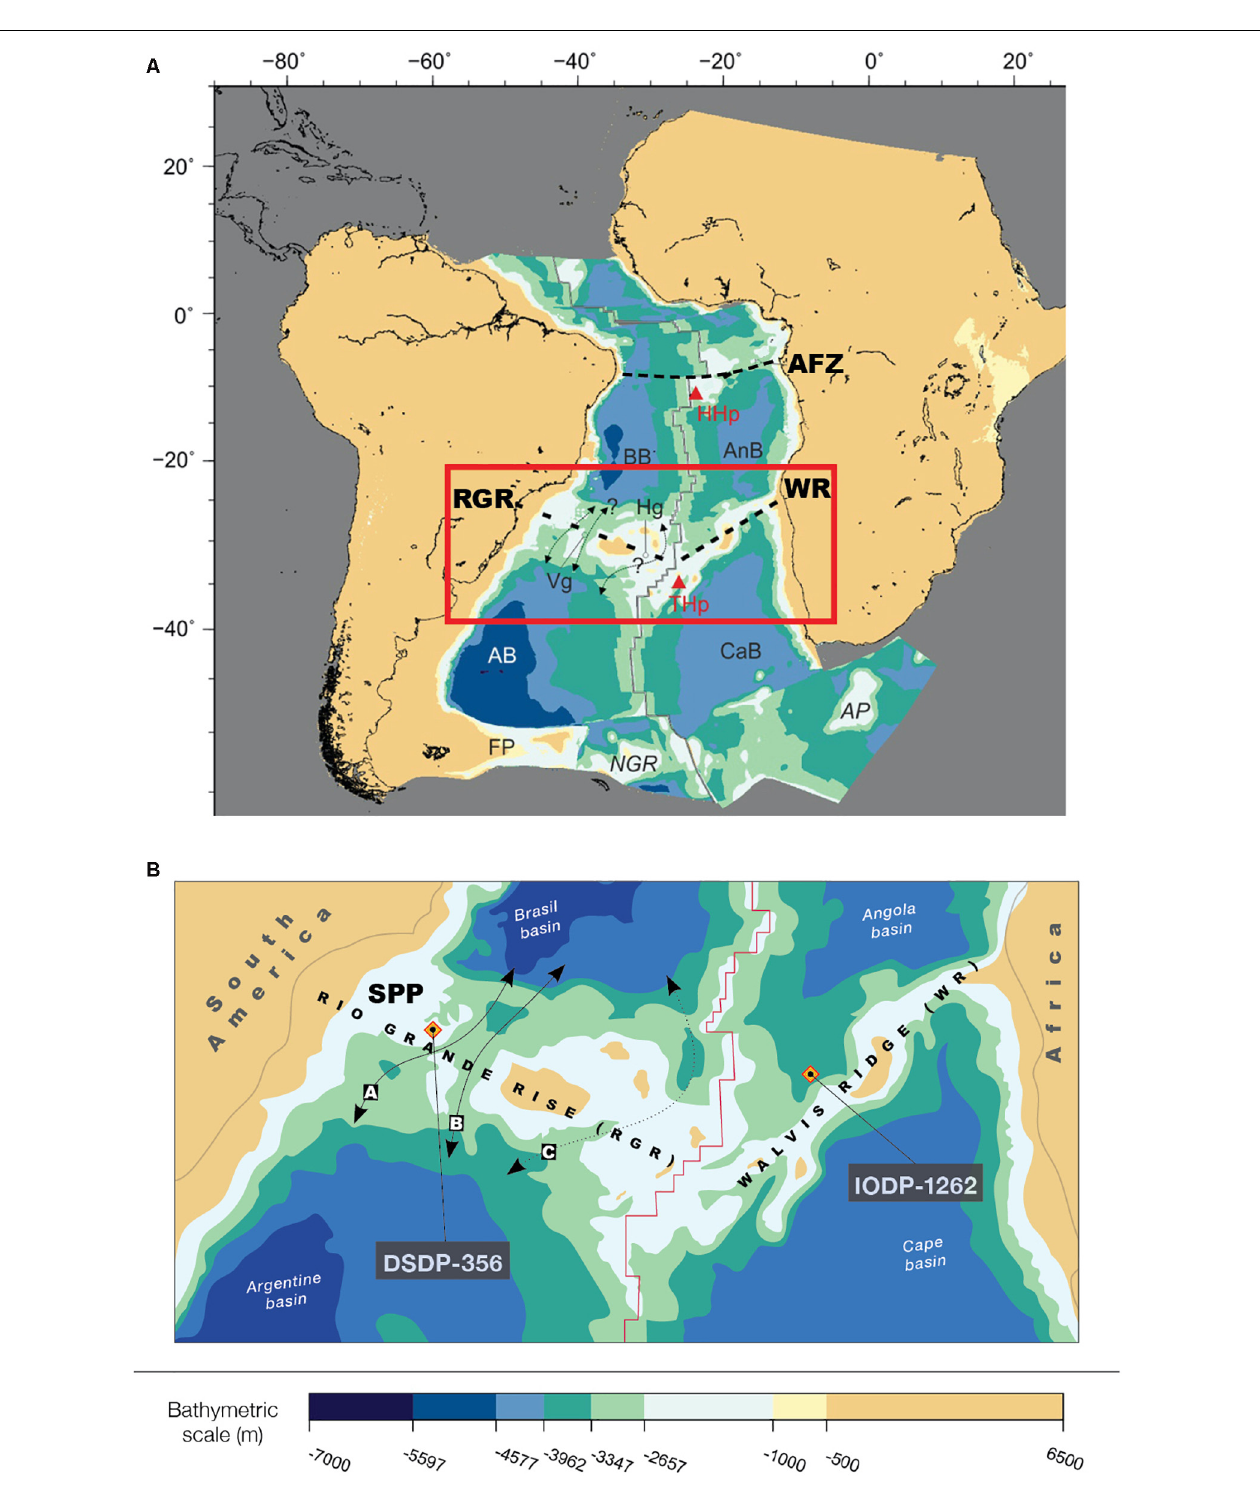
FIGURE 1 | Location of the Sao Paulo Plateau drill core [Deep-Sea Drilling Project (DSDP) Site 356] in the general paleogeographic context of the South Atlantic (A) , after Pérez-Díaz and Eagles (2017). Brazil Basin (BB) and Angola Basin (AnB) are bordered North by the Ascension Fracture Zone (AFZ) and South by the Rio Grande (RGR) – Walvis Ridge (WR) zone. South of this obstacle lay the Argentine Basin (AB), Cape Basin (CaB) and further toward the south the Falkland Plateau (FP), North Georgia Rise (NGR) and the Agulhas Plateau (AP) Red triangles represent hotspots: St Helena (HHp) and Tristan da Cunha (THp). (B) detail view of the drill core’s location, in the proximity of the Vema Gap (a,b) and Hunter Gap (c), the main oceanic passages across the Rio Grande Rise – Walvis Ridge system. Marked is also the International Ocean Discovery Program (IODP) Site 1262, discussed in the text.